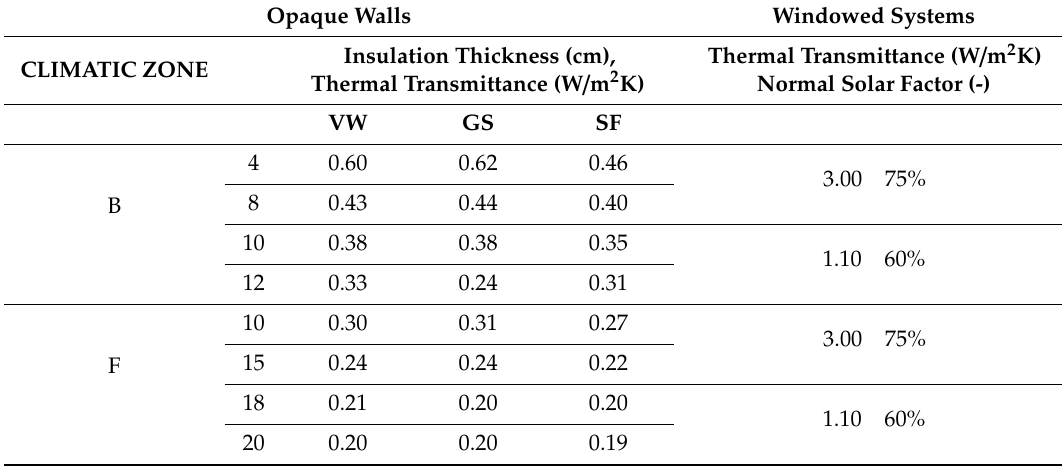
Table 4. Insulation thicknesses and thermal transmittances of opaque walls (VW, vertical wall; GS, ground slab; SF, second to last floor), thermal transmittances and normal solar factors of the windowed systems in climatic zones B and F.